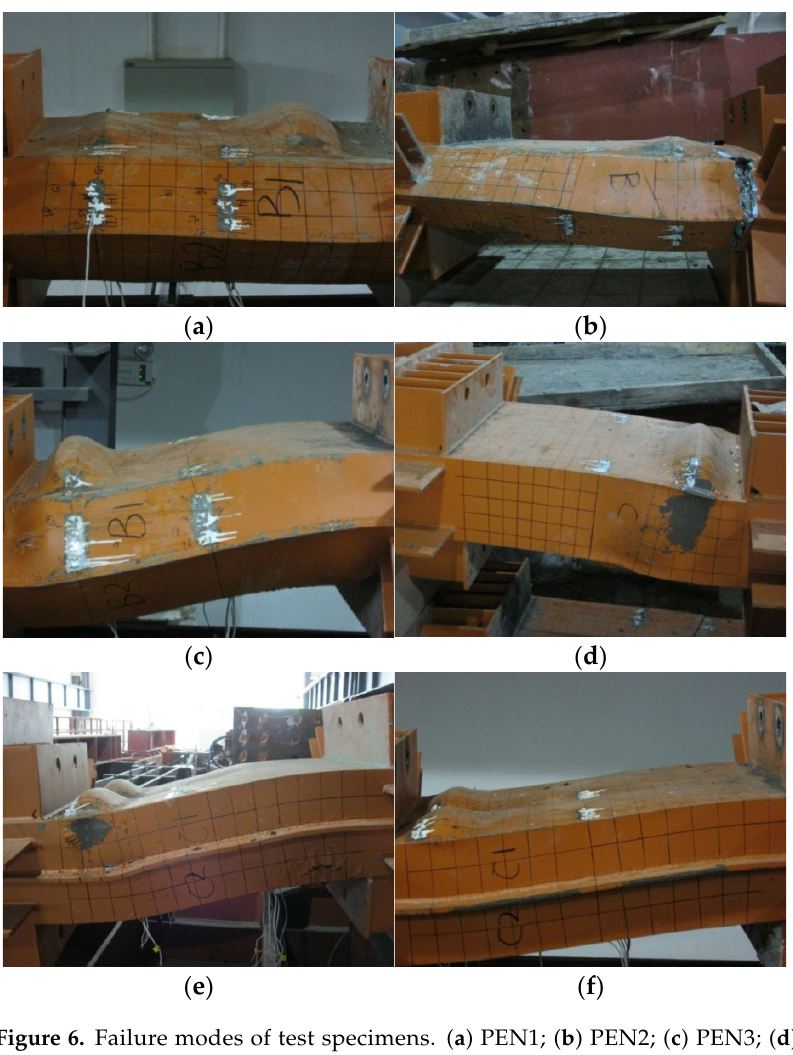
Figure 6. Failure modes of test specimens. ( a ) PEN1; ( b ) PEN2; ( c ) PEN3; ( d ) PEN4; ( e ) PEN5; ( f ) PEN6.